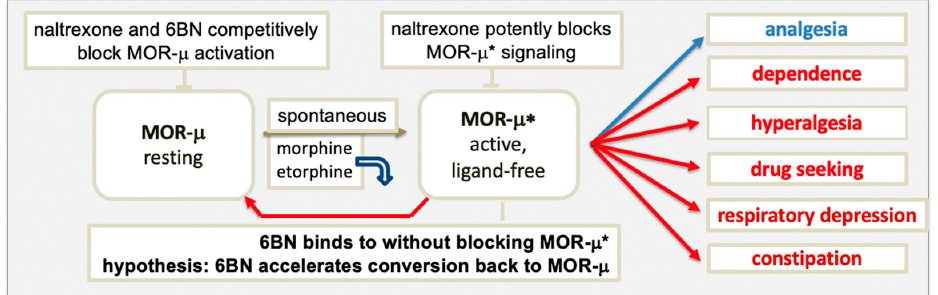
Figure 1. Model of μ opioid receptor (MOR) conformations. MOR- μ * is reversibly activated by both spontaneous conversion and agonists to ligand-free active MOR- μ *. Opioid agonists appear to dissociate from MOR- μ * by losing high-affinity binding. The inverse agonist naltrexone potently blocks ligand-free MOR- μ *, whereas the neutral antagonist 6BN binds to MOR- μ * but does not suppress signaling. Both naltrexone and 6BN block agonist activation competitively at MOR- μ with lower potency. Continued opioid agonist stimulation shifts the equilibrium to persistent MOR- μ * signaling, leading to a dependent state. In contrast to naltrexone, 6BN is proposed to potently accelerate reversal of the equilibrium back to MOR- μ in the opioid-naïve state. Adapted from [20].